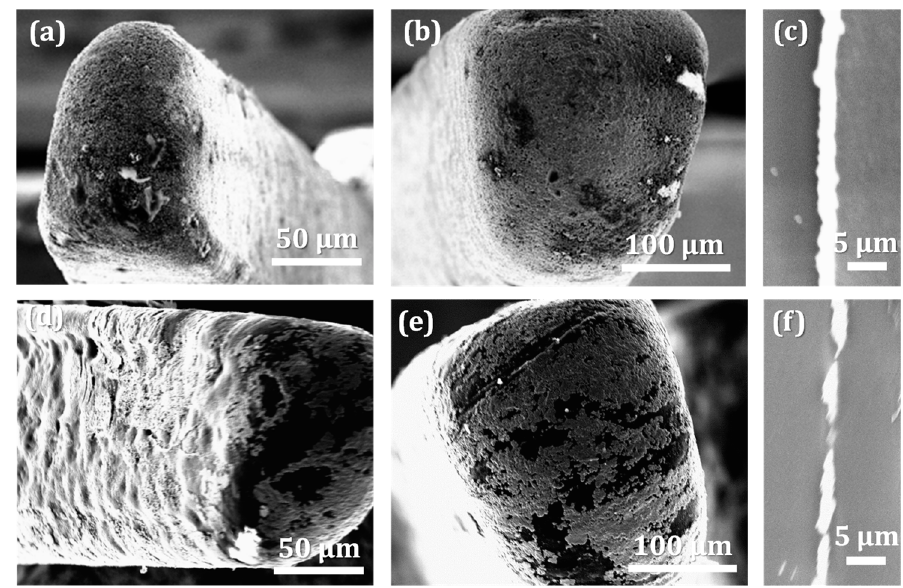
Figure 7. Metallization quality at the fingertips: ABS F8 ( a ); ABS F1 ( b ); PC-ABS F8 ( d ); PC-ABS F1 ( e ). The cross section of copper coating on ABS F8 ( c ) and on PC-ABS F8 ( f ).